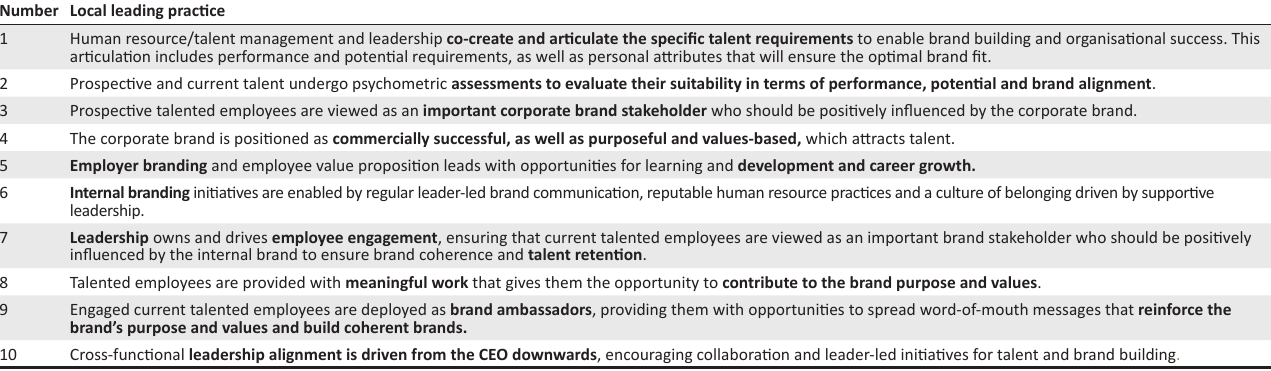
TABLE 3: Local leading practices in talent attraction and retention through brand building. Number Local leading